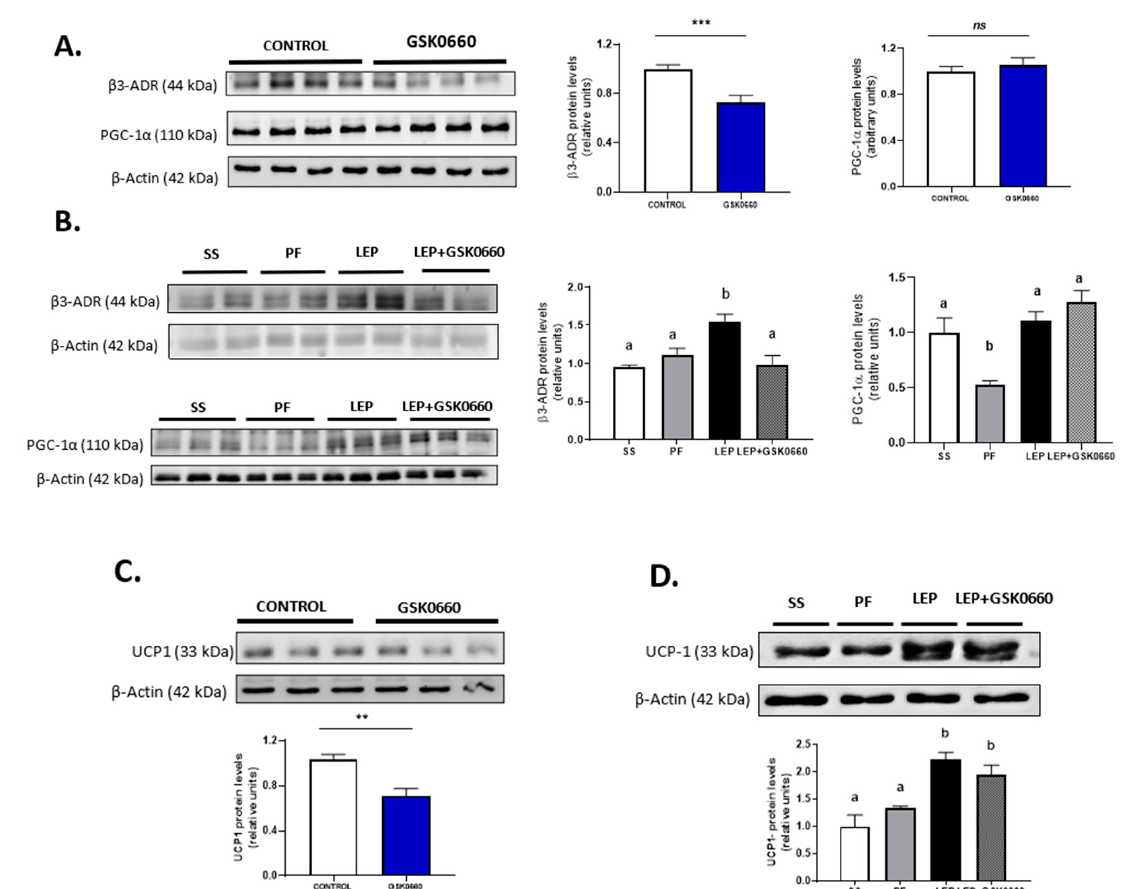
Figure 6. Representative Western blot of β 3-adrenergic receptor, PGC-1 α ( A ) and UCP-1 ( C ) protein levels and relative densitometric analysis in eWAT of rats after 7 days of vehicle (DMSO) control or intraperitoneal antagonist GSK0660 injection ( n = 6). ( B ) Representative Western blot of β 3-adrenergic receptor, PGC-1 α ( B ) and UCP-1 ( D ) protein levels and relative densitometric analysis in eWAT of rats after 7 days of chronic central treatment of vehicle (SS and PF), leptin, or leptin and ip GSK0660 co-administration ( n = 4–6). Densitometric levels of proteins are expressed relative to the Control group and SS group, the levels of which were set at 1.0 arbitrarily. Results are the mean ± SEM per group of animals ( n = 4–6). Differences between CONTROL vs. GSK0660 treatment were analyzed by Student’s t -test (** p < 0.05, *** p < 0.001; ns: non-significant). Significant differences between ICV-treated rats were analyzed by One-Way ANOVA followed by Tukey test (differences letters mean significant differences among treatments, p ≤ 0.05). a p ≤ 0.05 vs. PF or Lep or Lep+GSK0660; b p ≤ 0.05 vs. SS or PF or Lep+GSK0660. SS: vehicle-infused rats fed ad libitum, PF: vehicle-infused pair-fed rats;